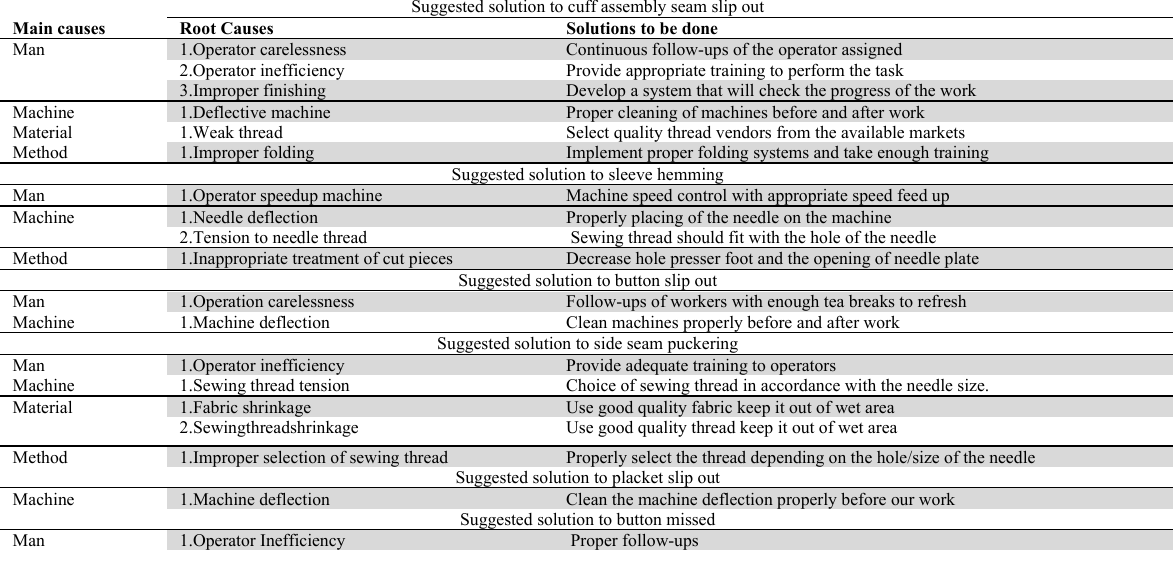
Suggested solution to minimize root causes for vital few shirts defects 6 Suggested solution to cuff assembly seam slip